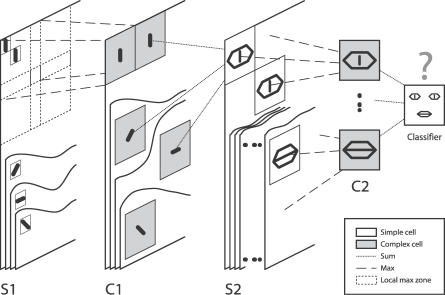
Overview of the Five-Layer Feedforward Spiking Neural NetworkAs in HMAX [7], we alternate simple cells that gain selectivity through a sum operation, and complex cells that gain shift and scale invariance through a max operation (which simply consists of propagating the first received spike). Cells are organized in retinotopic maps until the S2 layer (inclusive). S1 cells detect edges. C1 maps subsample S1 maps by taking the maximum response over a square neighborhood. S2 cells are selective to intermediate-complexity visual features, defined as a combination of oriented edges (here we symbolically represented an eye detector and a mouth detector). There is one S1–C1–S2 pathway for each processing scale (not represented). Then C2 cells take the maximum response of S2 cells over all positions and scales and are thus shift- and scale-invariant. Finally, a classification is done based on the C2 cells' responses (here we symbolically represented a face/nonface classifier). In the brain, equivalents of S1 cells may be in V1, S2 cells in V1–V2, S2 cells in V4–PIT, C2 cells in AIT, and the final classifier in PFC. This paper focuses on the learning of C1 to S2 synaptic connections through STDP.